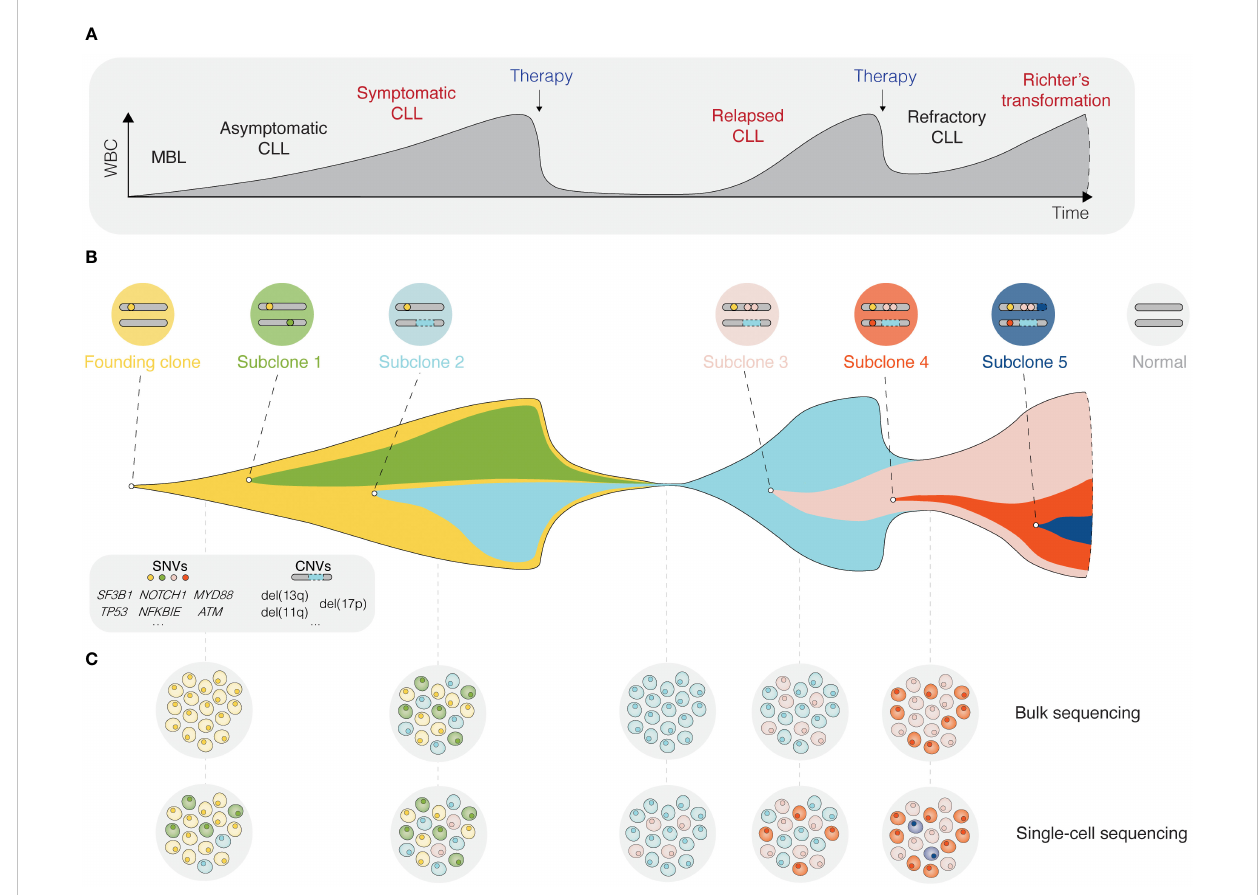
FIGURE 2 Single-cell sequencing deciphers cellular heterogeneity. (A) Schematic presentation of the different stages for a typical CLL patient, from the precursor condition monoclonal B cell lymphocytosis (MBL) to relapsed/refractory CLL, and in some cases Richter ’ s transformation. (B) The fi sh plot depicts tumor evolution in which multiple subclones exist within a leukemic cell population. While some clones are eradicated by therapy, others accumulate mutations that confer a clonal advantage. (C) The depth of bulk sequencing primarily allows detection of dominant subclones only, whereas single-cell analyses have the potential to detect all subclones, including minor ones as soon as they arise. WBC, white blood count; MBL, monoclonal B cell lymphocytosis; SNV, single nucleotide variant; CNV, copy-number